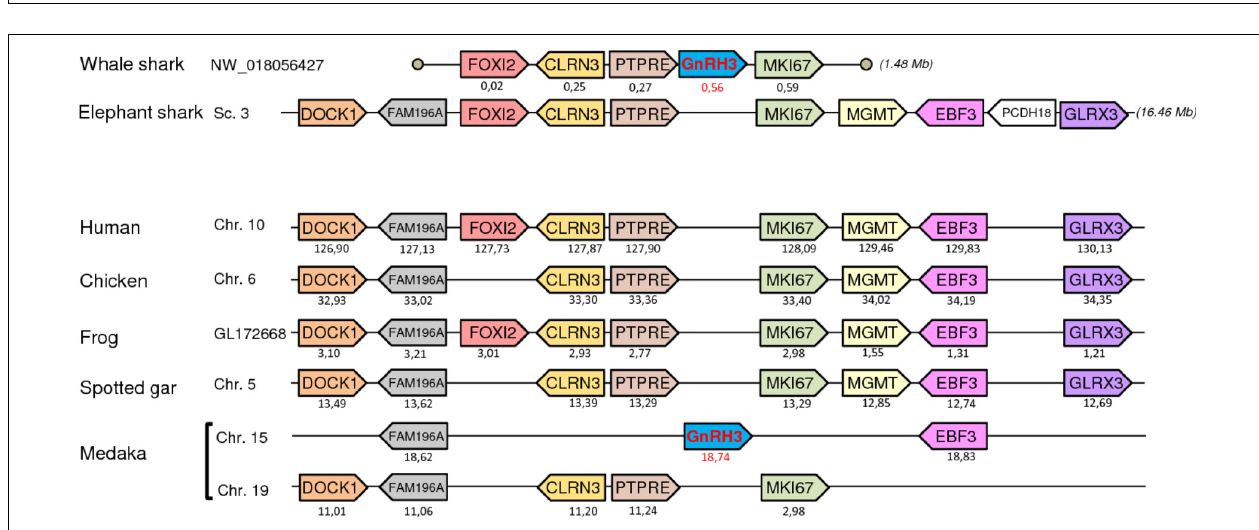
FIGURE 5 | Synteny of genes in the GnRH2 locus in catshark, whale shark, and elephant shark plus five selected bony vertebrate species (human, chicken, western clawed frog, spotted gar, and medaka). Legends are the same as in the Figure 4 .